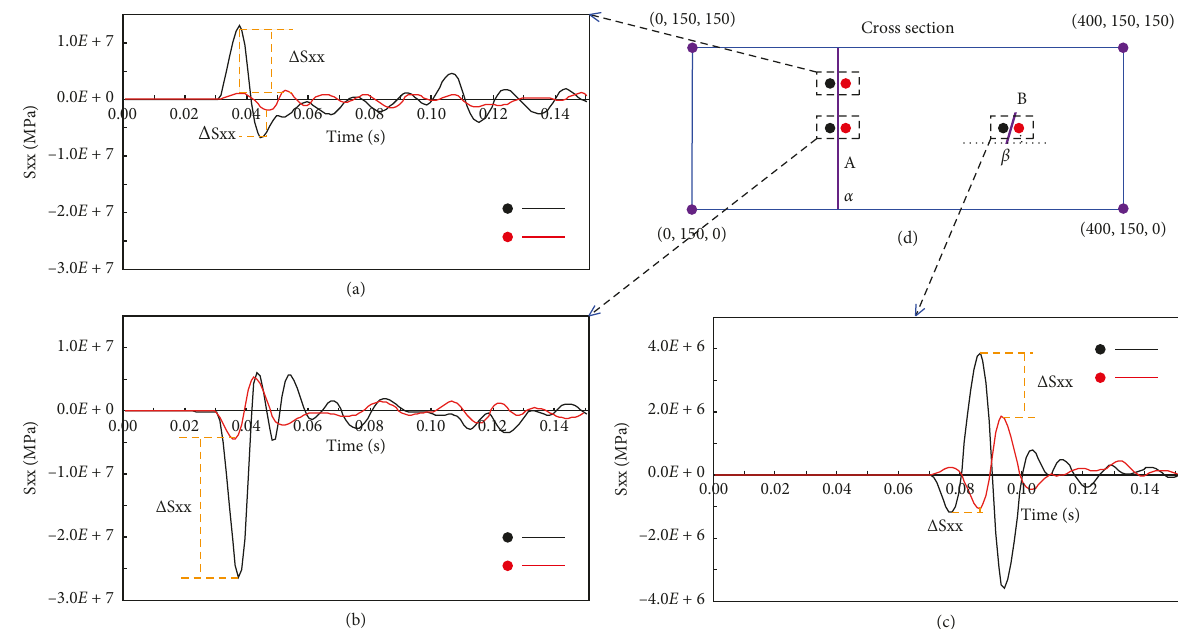
Figure 7: The evolution and attenuation of stress in the XX direction (Sxx, MPa) recorded at six passive particles (indicated by the black and red points, faults A and B are shown by the purple lines) influenced by the stress wave. Panel (d) is a cross section extracted in the middle of the model box (Figure 1). The Y -axis represents Sxx (MPa), and the X -axis is the duration of running model. Δ Sxx is used to show the difference of the first and/or second waves’ amplitude (orange dotted line), which could help indicate the attenuation degree due to the absorption or resistance effect of weak